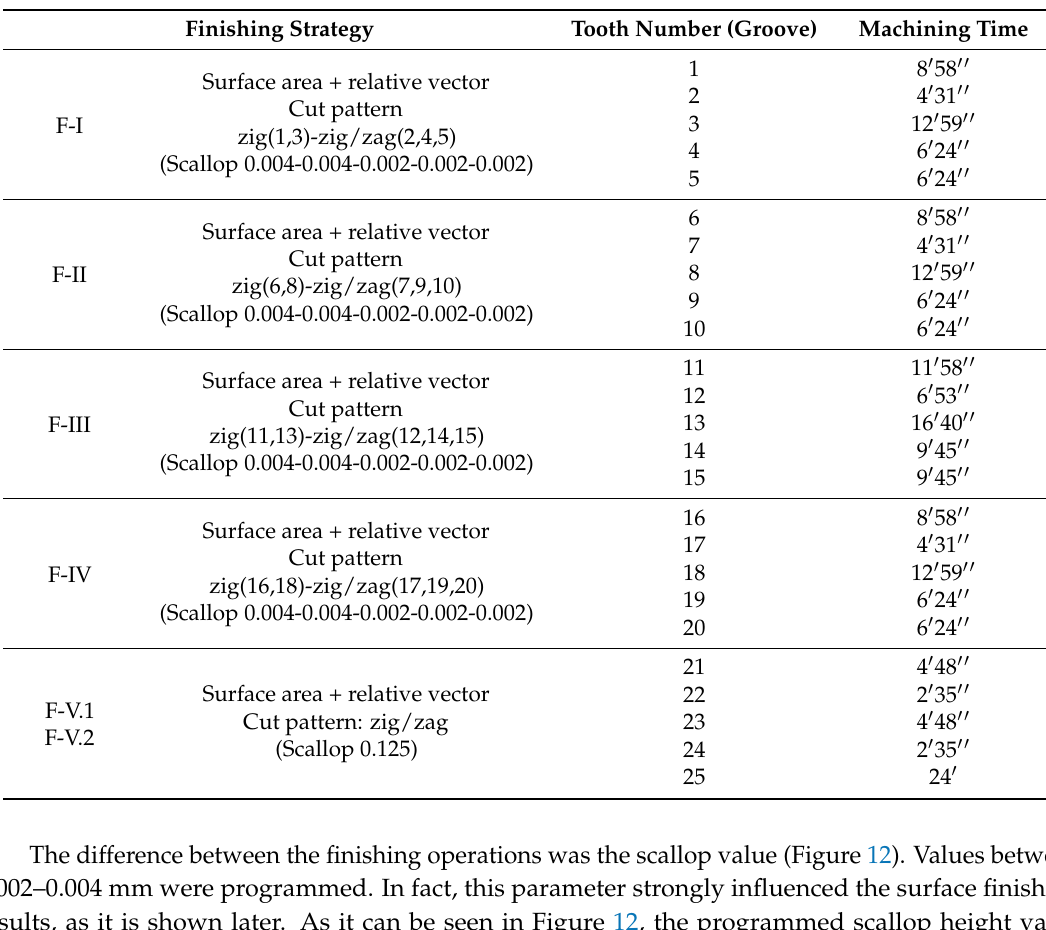
Table 5. Finishing strategies information.